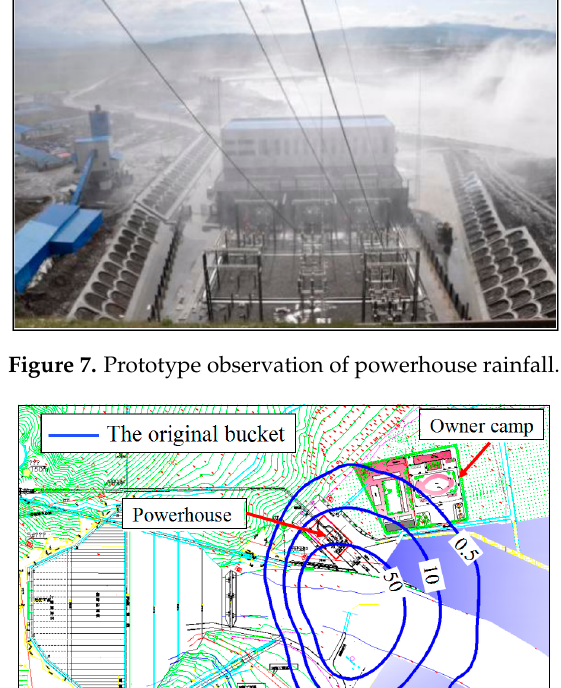
Figure 8. Rainfall intensity distribution of prototypical numerical results (unit: mm h − 1 ).